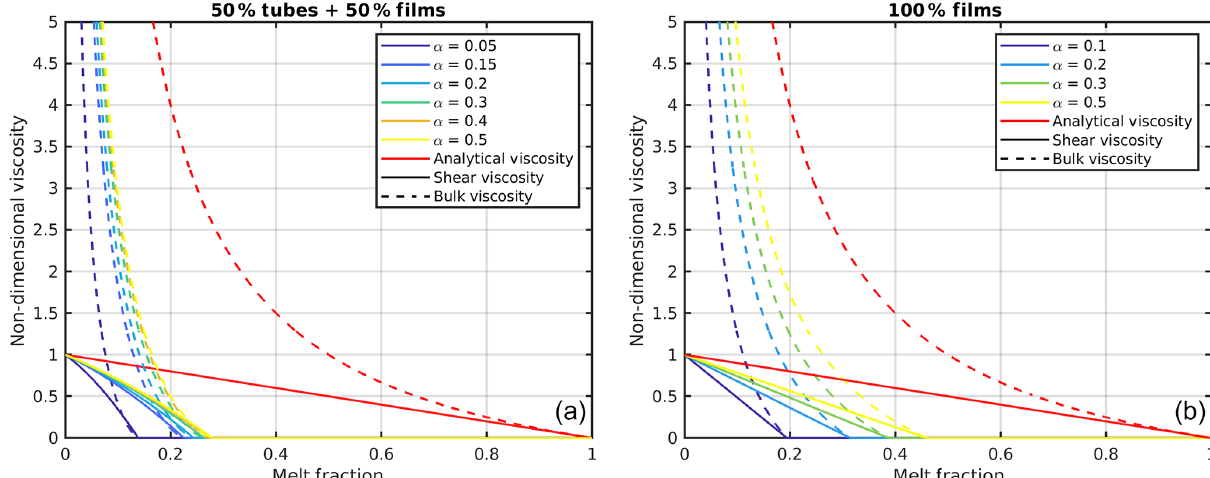
Figure 1. Shear (solid) and bulk (dashed) viscosity for several aspect ratios as a function of the melt fraction. (a) The viscosities are calculated for a melt network consisting of 50% tubes and 50% films. (b) The network consists of 100% films. The red lines show the simplified analytical viscosities (Eqs. 1 and